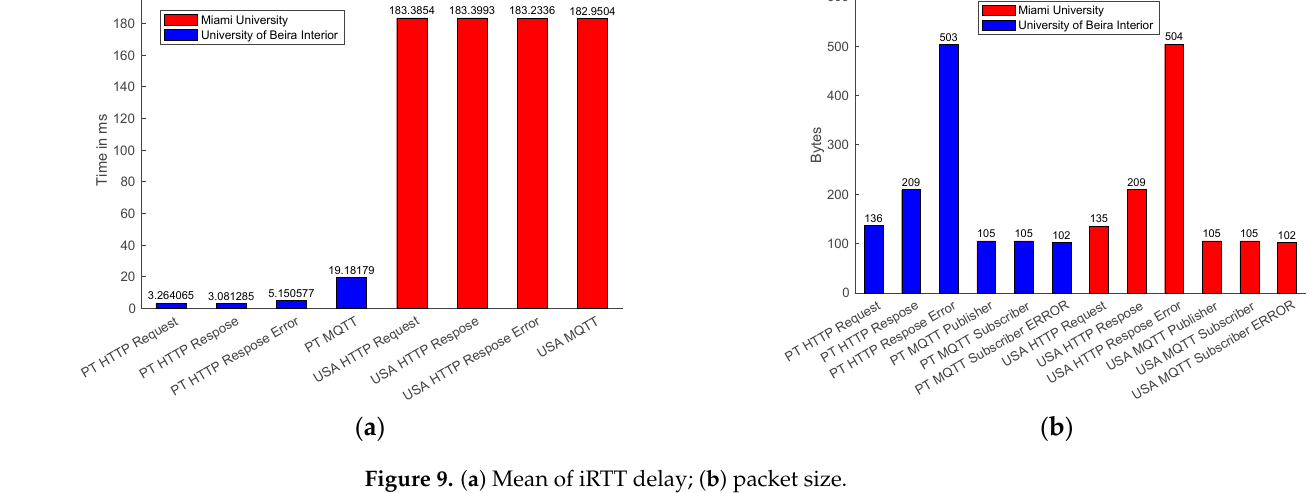
Figure 10. Packet loss. The mean, standards deviation, median, minimum, and maximum values from the communication time from the communication that starts in Portugal and finishes in Por- tugal are presented in Table 1, and for communication that starts and ends in the USA are shown in Table 2. Table 1. Communication that starts and ends in Portugal. Time in Milliseconds